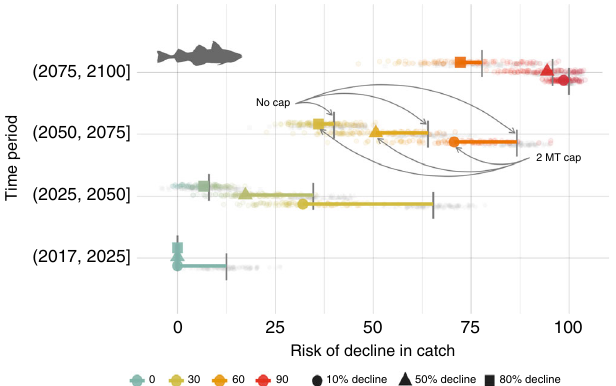
Fig. 5 Change in risk of decline in pollock catch under climate change (RCP 8.5) relative to the climate persistence scenario. Risk includes risk of decline (>10% decline), severe decline (>50% decline) and collapse (>80% decline) in catch during four time periods for scenarios without the cap (gray points) and those with the 2 MT cap. The color scale represents relative risk (0 – 100) from low (teal) to high (red). Length of segments indicate the magnitude of change in risk between the no cap and 2 MT cap scenarios. Vertical gray segments indicate the mean of the “ no cap ”